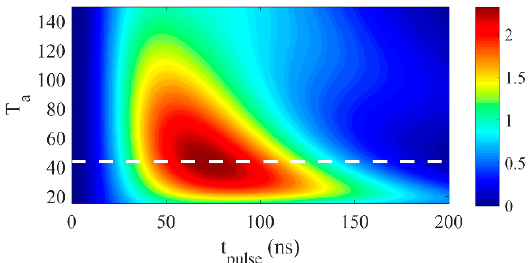
Figure 3. Dependence of I peak on the optical thickness, T a , and time, t pulse , according to Equations (20) and (22) at p = 1.84, γ S = 2.35 Γ 0 , γ a = 0.5 Γ 0 , Δ = 0.94 Γ 0 , and T e = T a /180. The white dashed line corresponds to T a = 44, at which the peak pulse intensity is the maximum at the moment t pulse = 72 ns and is 2.34 times higher than the peak intensity of the incident photon. Here, I peak is normalized to the peak intensity of the incident photon wave packet.